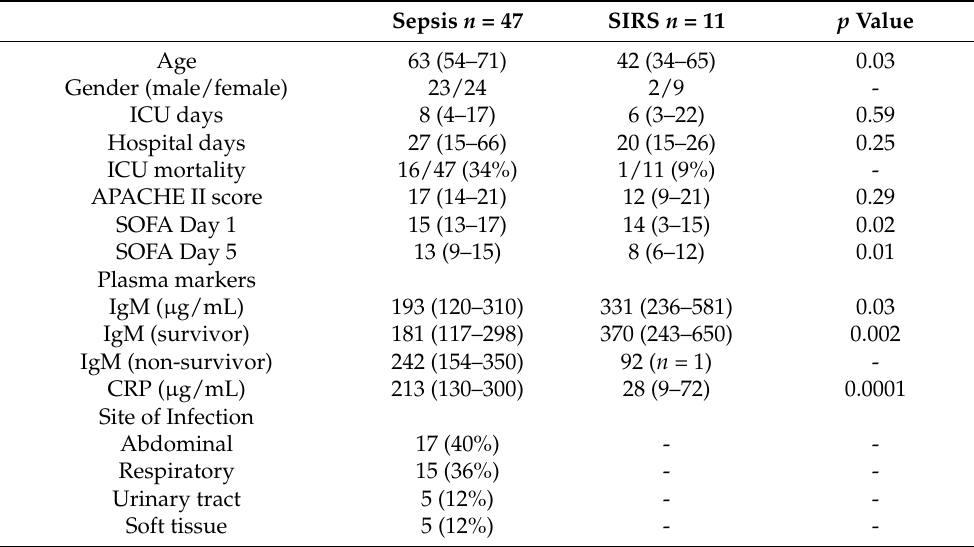
Table 1. Comparison of patient characteristic, outcome, plasma biomarker levels and site of infection in sepsis and